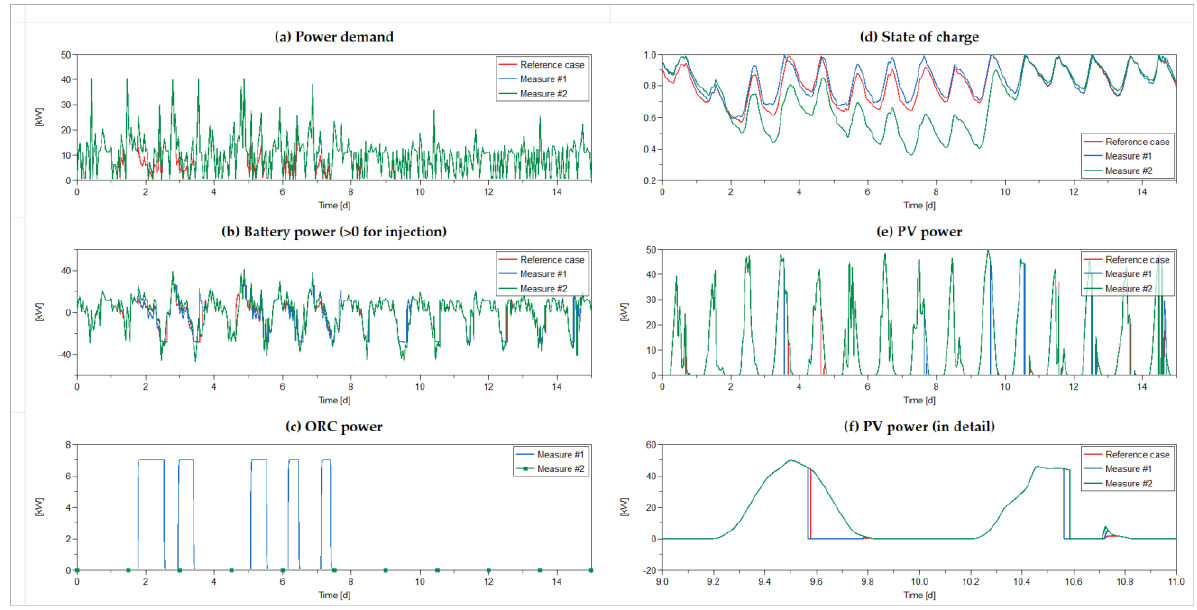
Figure 15. Power balance and state of charge (SoC) evolution during the period examined. ( a ) Power demand, ( b ) injected battery power, ( c ) ORC power, ( d ) battery SoC, ( e ) PV power and ( f ) PV power between days 9 and 11 in detail.